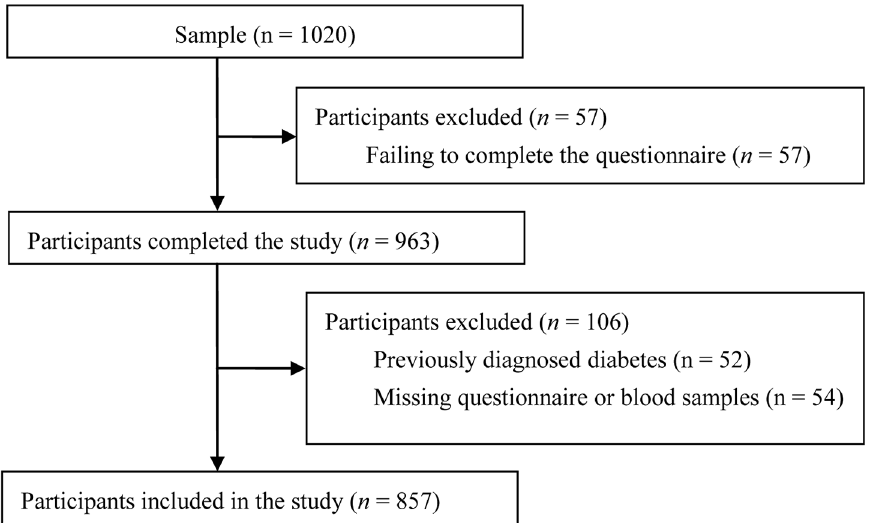
Fig 1. Flow diagram of the recruitment of Chinese